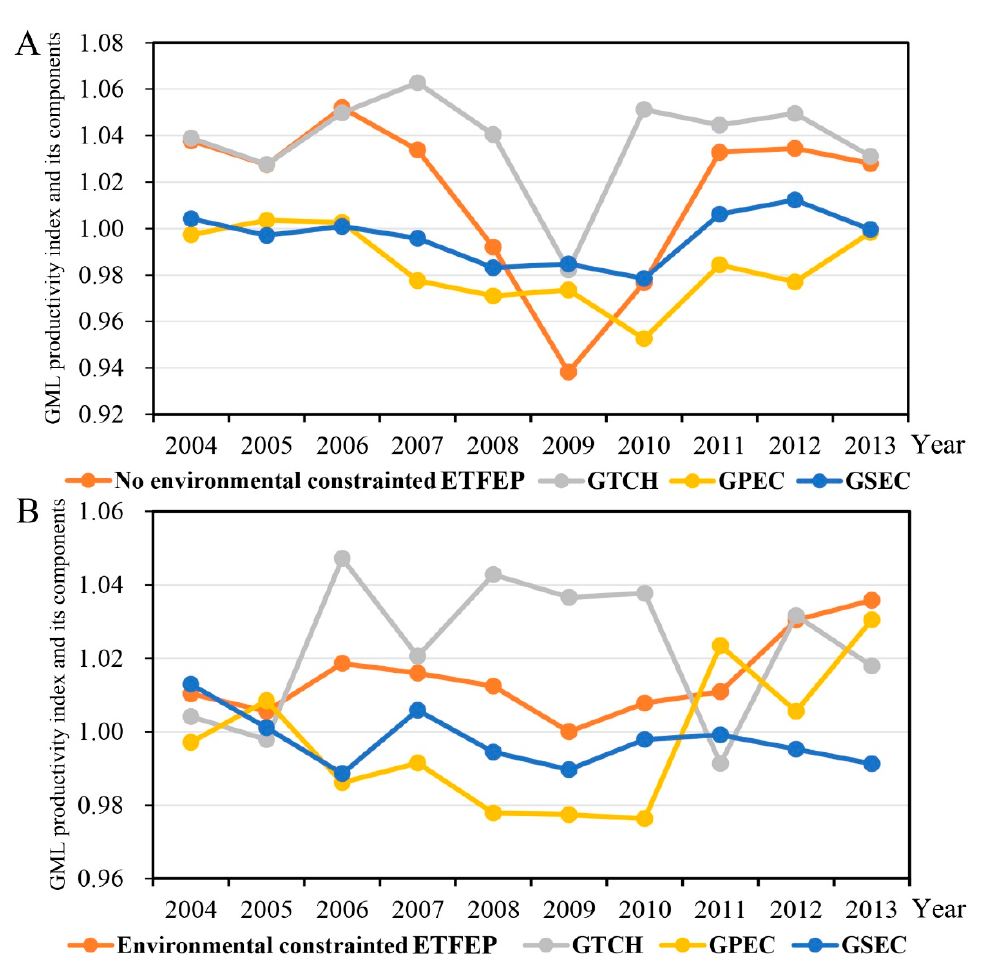
Figure 3. Inter-annual change of ETFEP indexes with and without environmental constraints. ( A ): Changes of ETFEP index and its components with no environmental constrained; ( B ): Changes of ETFEP index and its components with environmental constrained.